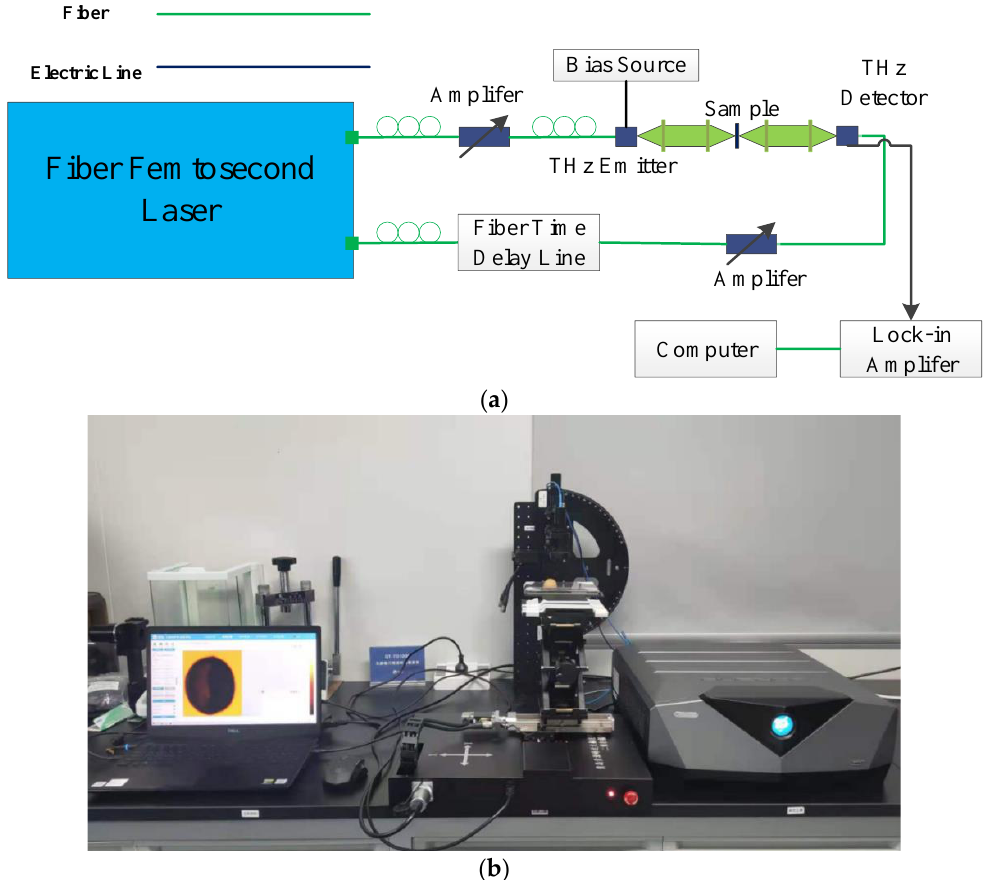
Figure 2. ( a ) Schematic diagram of QT-TS1000 terahertz spectral imaging system. ( b ) Physical picture of QT-TS1000 terahertz device.